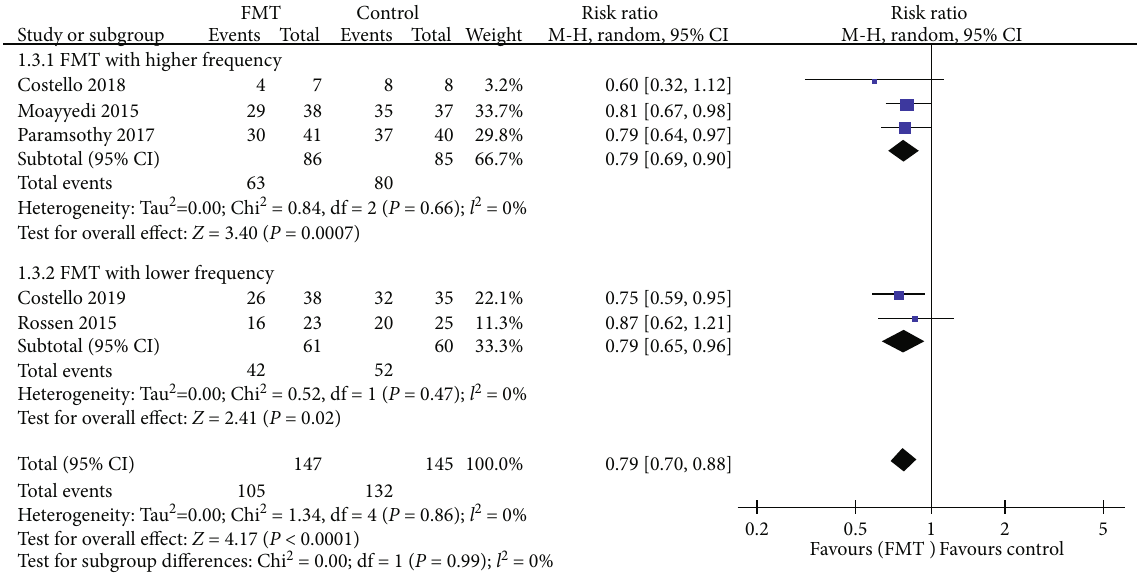
Figure 5: Forest plot of studies reporting combined clinical remission with endoscopic remission/response and subgroup analysis according to frequency of FMT administration.